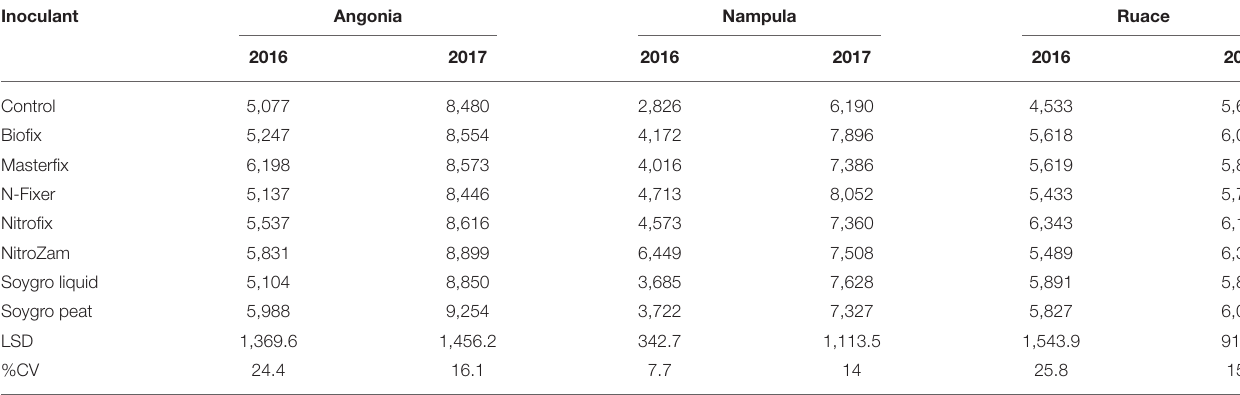
TABLE 7 | Harvest biomass (kg ha − 1 ) inoculants during the 2016 and 2017 growing seasons at Angonia. Inoculant